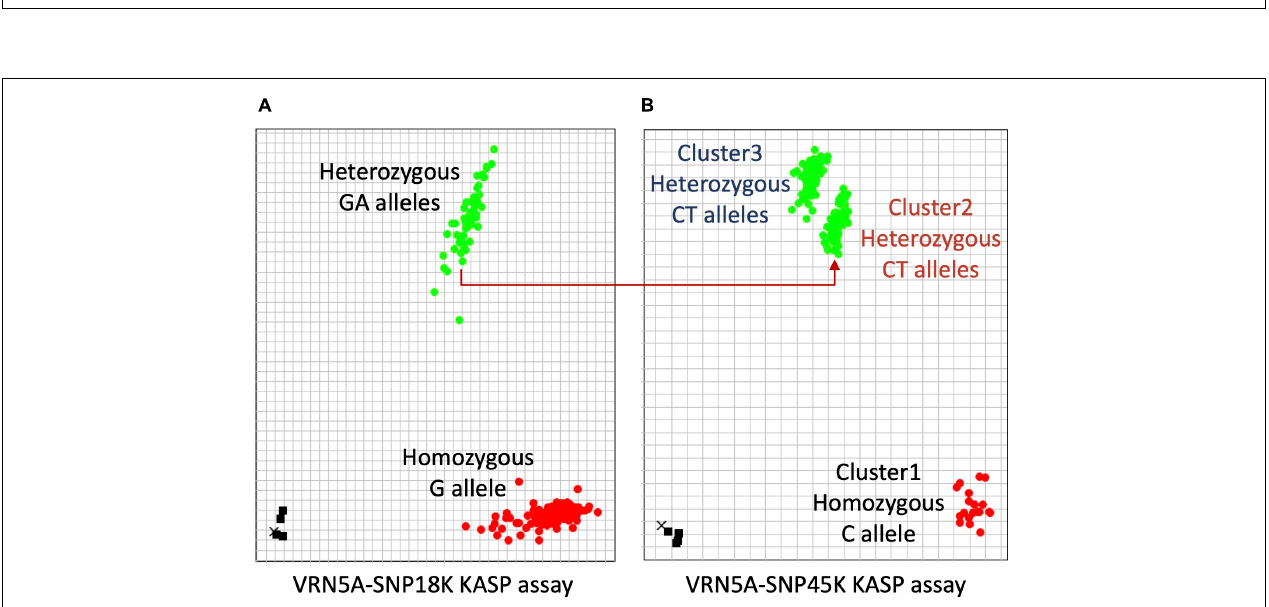
FIGURE 4 | Two genotyping plots of KASP assays used for identifying the copy number of VRN-A1 . (A) Plot of KASP assay for SNP18 in the first intron shows that the cultivars carrying the genotype group GT6 (four haplotypes/four copies) were assigned to the heterozygous cluster GA. (B) Plot of KASP assay for SNP45 in exon 4 shows that all cultivars containing three copies of VRN-A1 were assigned to the heterozygous Cluster3.